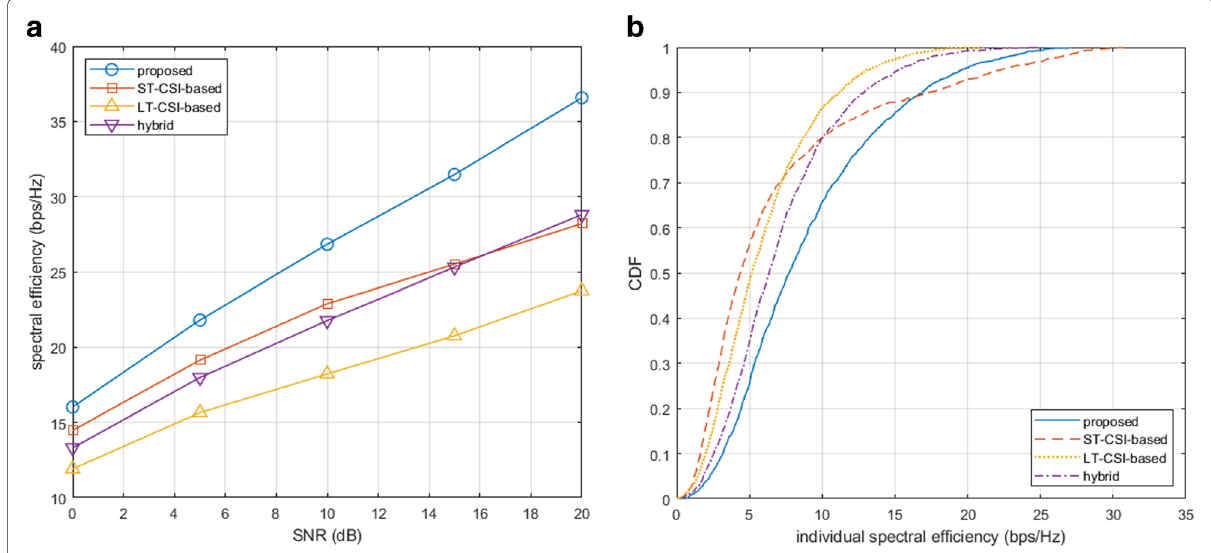
Fig. 3 Spectral efficiency in random velocity. a Spectral efficiency. b Empirical CDF of spectral